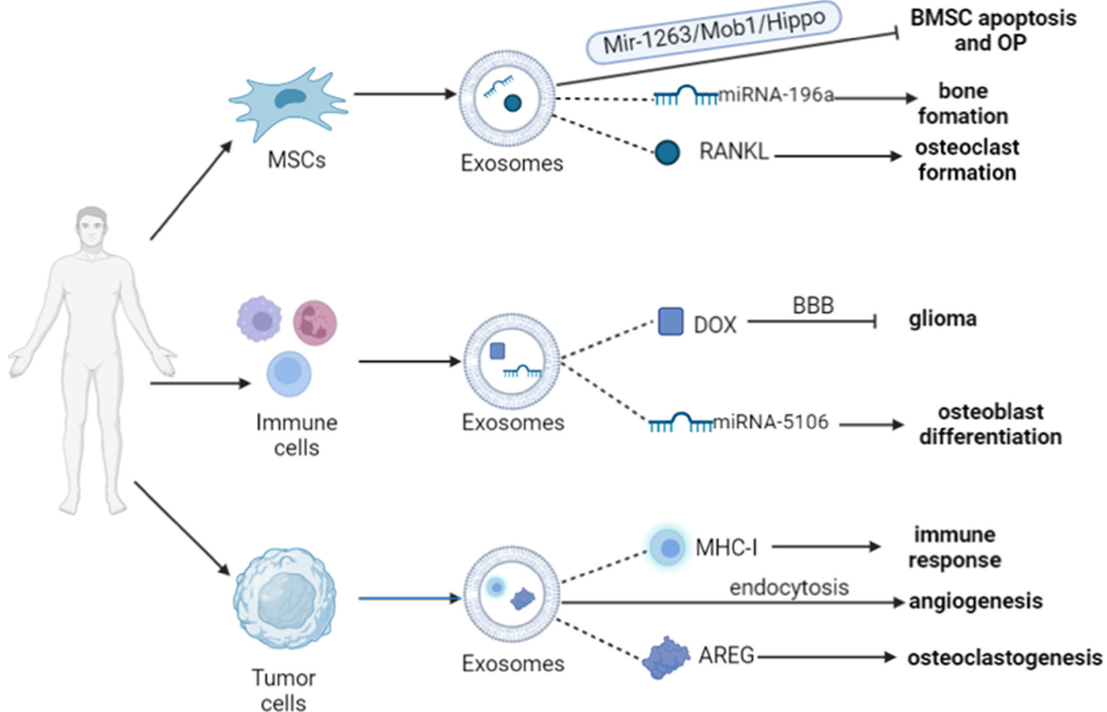
Figure 2. The roles of exosomes from different cells as drug delivery carriers. Exosomes from different cells release a variety of bioactive molecules that are involved in a wide range of diseases.